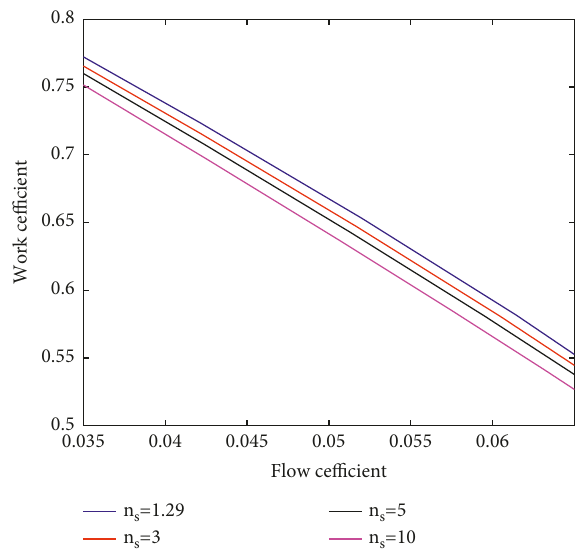
Figure 5: Isentropic exponent effects on the diffuser outlet Mach number.